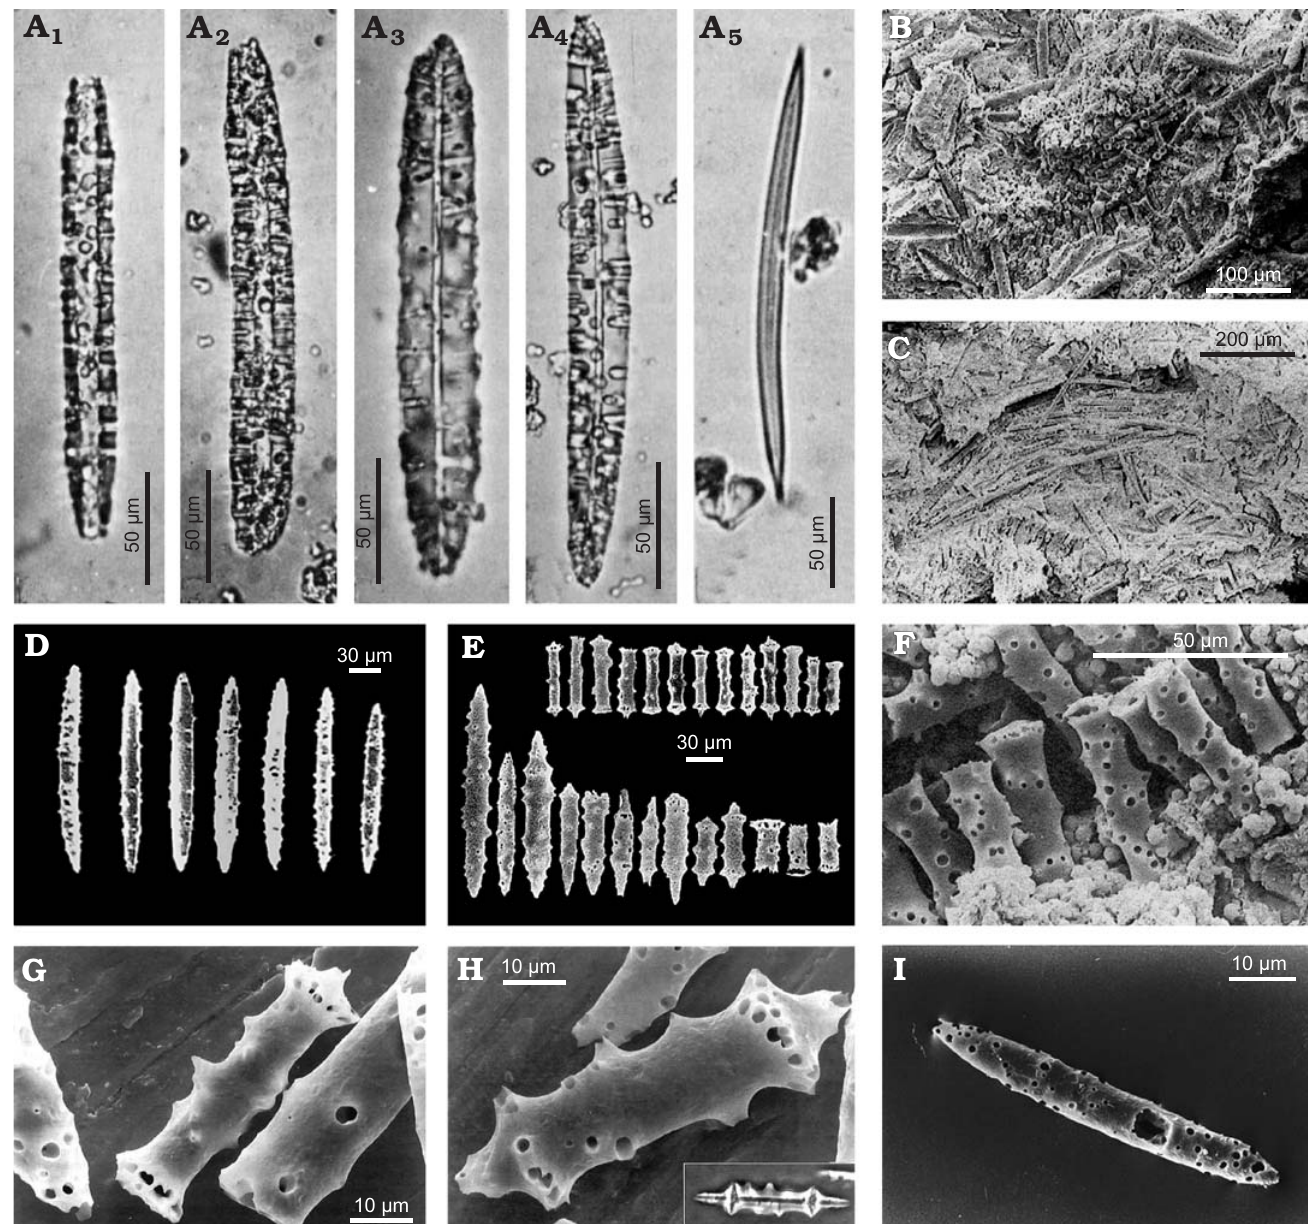
Fig. 16. Ephydatia gutenbergiana (Müller, Zahn, and Maidhof, 1982), Spongillida: Spongillidae; middle Eocene, Messel, Germany. A . Five oxeas as represented in the original description. B . Entire gemmule. C . Skeletal network (line-like arranged megascleres). D . Megascleres. E . Gemmuloscleres, the transitional forms of the series a (bottom, right) could point out an origin of the birotules from oxeas with shortened shaft. F . Corroded gemmulo- scleres. G , H . Two illustrations of gemmuloscleres that has been shifted from the genus Spongilla to the genus Ephydatia ; insert in H shows gemmulo- sclere in phase contrast. I . Megasclere, original material with corrosion marks that are characteristic for Messel. Modified from: A, Müller et al. (1982); B, F, Richter and Wuttke (1999); G, H, Richter and Wuttke (1995); I, Richter and Baszio References : Müller et al. 1982; Richter and Wuttke, 1995; Richter and Baszio 2000, 2001, 2009; Richter et al. 2017. Description (emended from Müller et al. 1982).—Megascle- res oxeas of two dimensional classes (140–230 × 15–20 μ m; 200–350 × 10–20 μ m). Gemmuloscleres similar smaller ox- Fig. 16. eas (50–150 μ m in length). Gemmules (structure interpreted as) with an extremely large diameter > 2 mm. Type horizon : Middle Eocene. Redescription (emended from Richter and Wuttke 1995; Type locality : Messel, Germany.